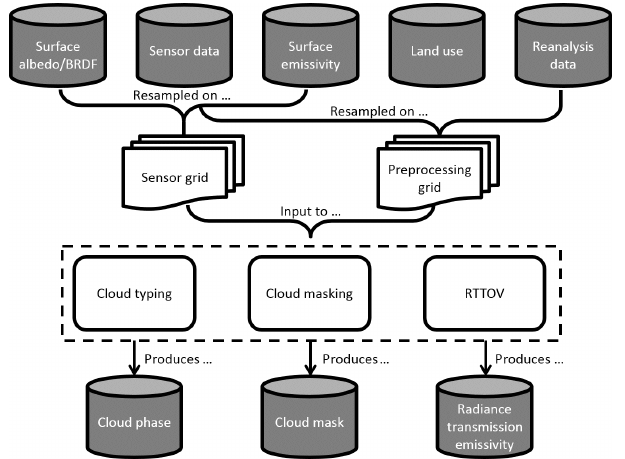
Figure 1. Schematic of the CC4CL preprocessor.